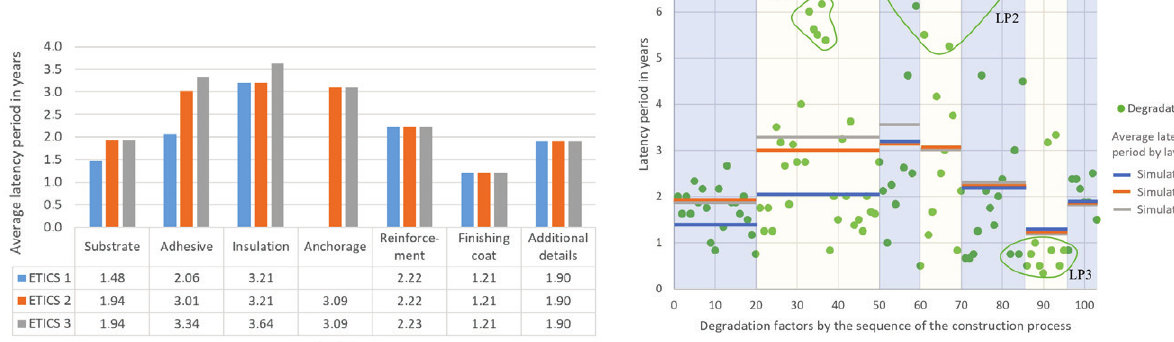
Figure 4. Latency period of the degradation factors by the sequence of the construction